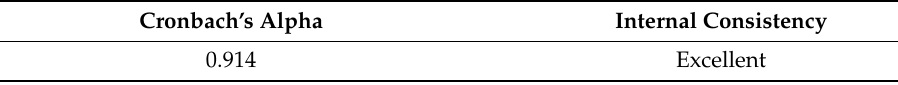
Table 4. Overall reliability of the research questionnaire.